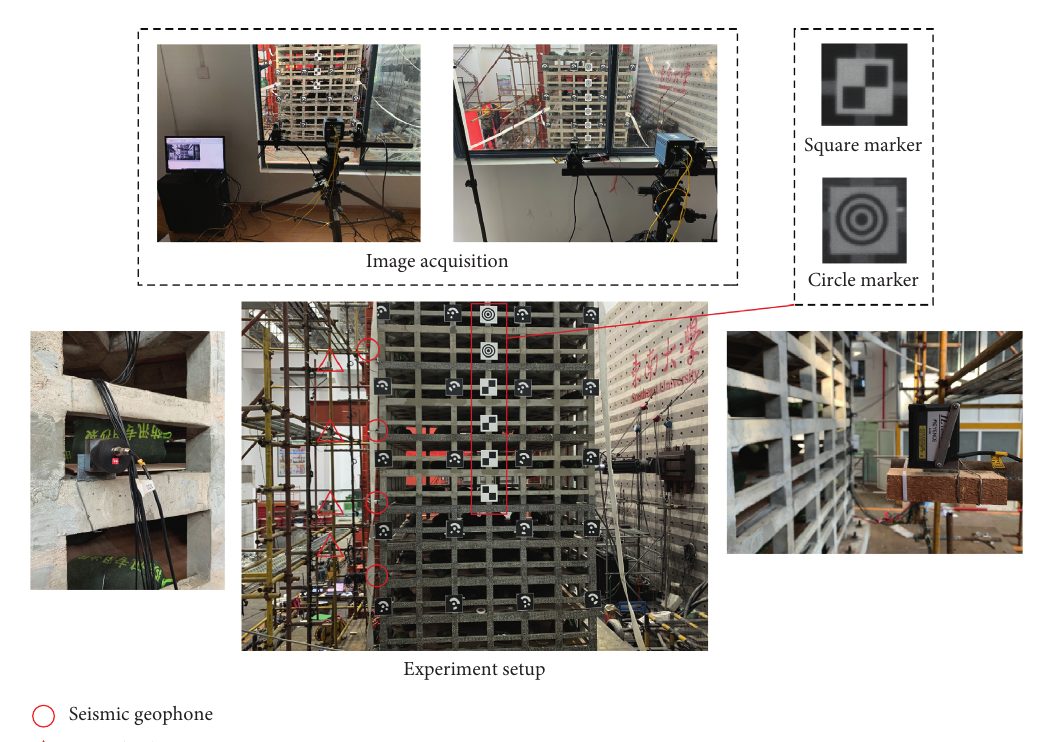
Figure 2: Experiment